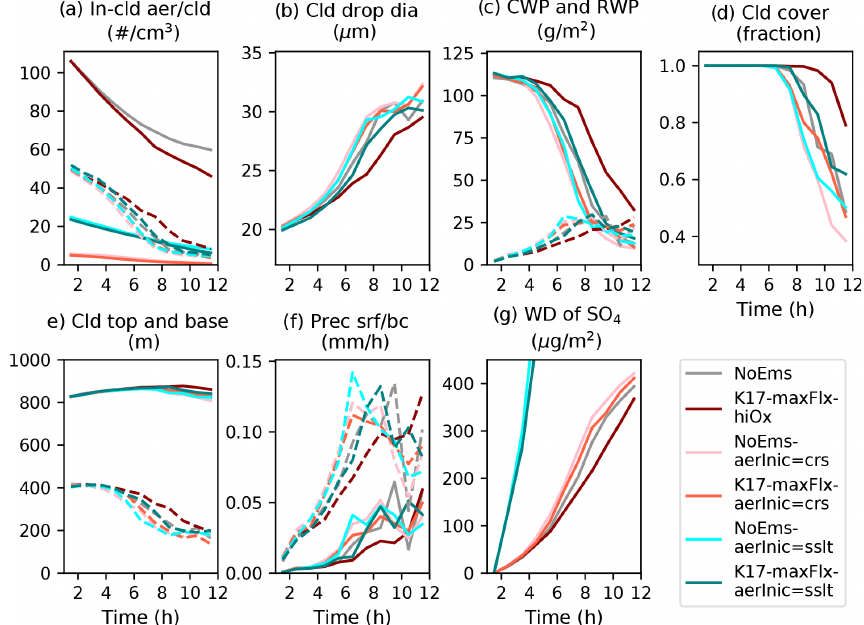
Figure 11. Impact of background aerosol on VOC effect. Dark red (K17-maxFlx-hiOx) – maximum fluxes of monoterpenes and isoprene emitted, higher oxidant levels, background aerosol initialized with Ackerman et al. (2009) size distribution; grey – no-emission control case for K17-maxFlx-hiOx; red (K17-maxFlx-aerInic = crs) – VOCs same as K17-maxFlx-hiOx, fine mode removed from the initial background aerosol; pink – no-emission control for K17-maxFlx-aerInic = crs; teal (K17-maxFlx-aerInic = sslt) – VOCs same as K17-maxFlx-hiOx, background aerosol initialized with sea salt size distribution from Fuentes et al. (2010); cyan – no-emission control for K17-maxFlx- aerInic =